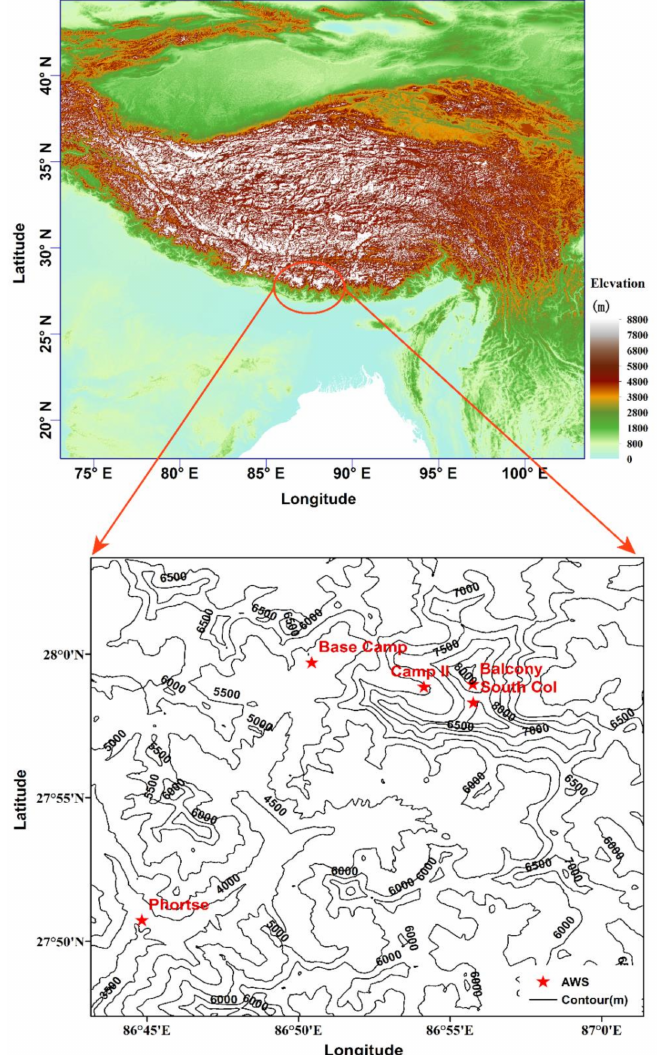
Figure 1. The topography of Mt. Everest and its surroundings. The selected meteorological stations are shown with red